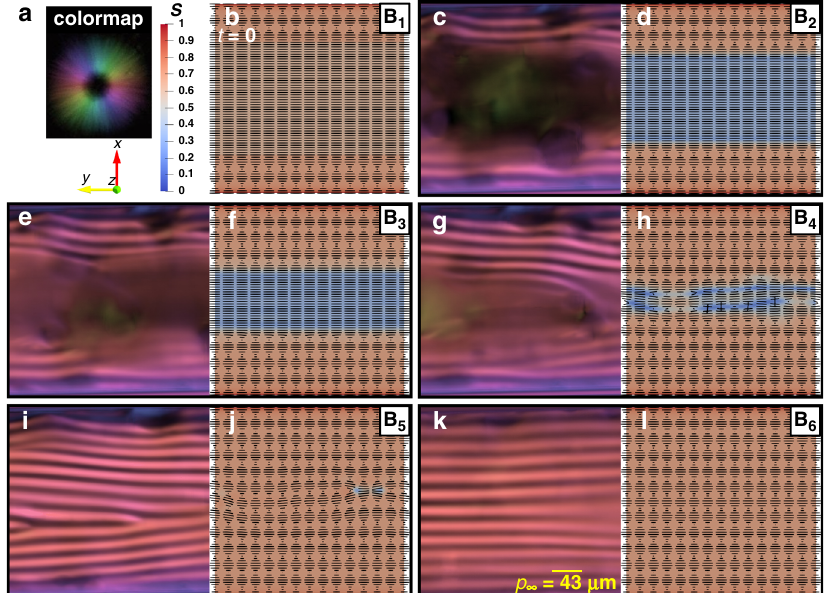
Fig. 2 Mechanism of slow – fast dynamic in BLG relaxation. a The colormap indicating the fi bers orientation in the experimental POM panels captured by the LC PolScope device (see Supplementary Note 1 for further information), the blue-to-red spectrum showing the order parameter, S , computed by direct numerical simulation (see Supplementary Note 6 for further information), and the coordinate system. b Initialization of director fi eld in direct numerical simulation, representing the initial con fi guration of fi bers. c , e , g , i , k The experimental POM panels corresponding to the B 2 to B 6 stages shown in Fig. 1m. d , f , h , j , l The schematic fi bers orientation and their order parameter computed by direct numerical simulation in the lateral plane for the B 2 to B 6 stages shown in Fig. 1m. General Note: the label numbers from B 1 through B 6 are marked in Fig.